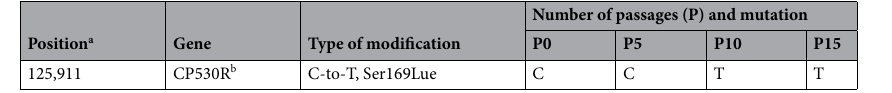
Table 1. A mutation accumulated in the genome DNA of ASFV Armenia07 isolate by serial passages in IPKM cells. a Nucleotide position number is based on the sequence of the ASFV Georgia 2007/1 isolate [GenBank accession no. FR682468]. b The CP530R encodes polyprotein, pp60, which is cleaved to p35 and p15. These proteins form the major components of the core shell of the